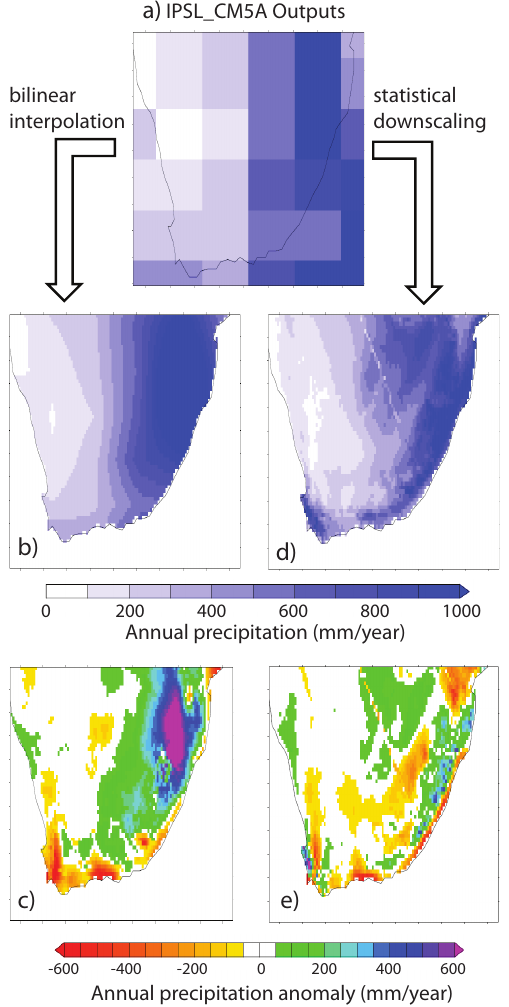
Figure 3. (a) Annual precipitation (mmyr − 1 ) for present day simu- lated by IPSL_CM5A over southern Africa (average over the years 1960–1990 from a 20th century simulation). Annual precipitation simulated by IPSL_CM5A for present day with a spatial resolution increased to 0.16 ◦ through a bilinear interpolation (b) and differ- ence with the CRU data (IPSL_CM5A – CRU) (c) . Annual precipi- tation simulated by IPSL_CM5A for present day with a spatial res- olution increased to 0.16 ◦ through statistical downscaling (d) and difference with the CRU data (IPSL_CM5A – CRU) (e)